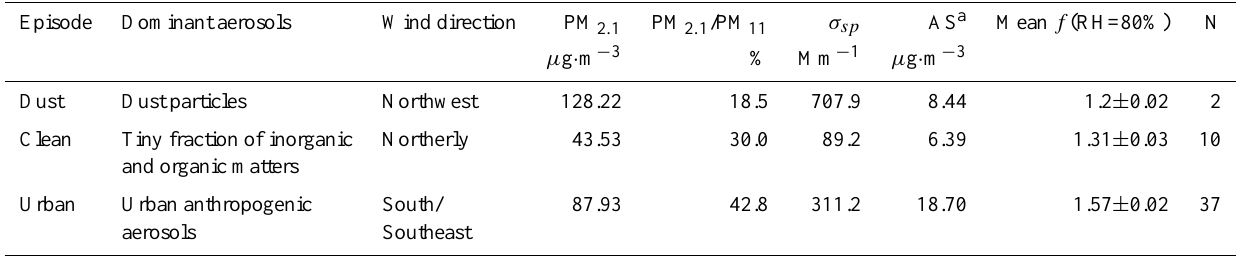
Table 2. Designation of different dominant types of aerosols.